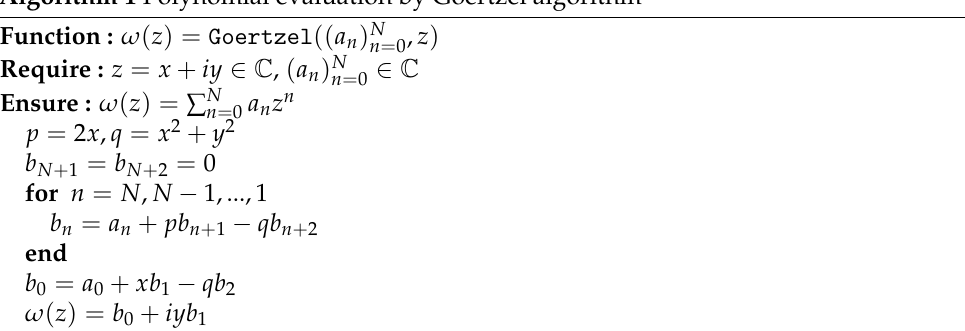
Algorithm 1 Polynomial evaluation by Goertzel